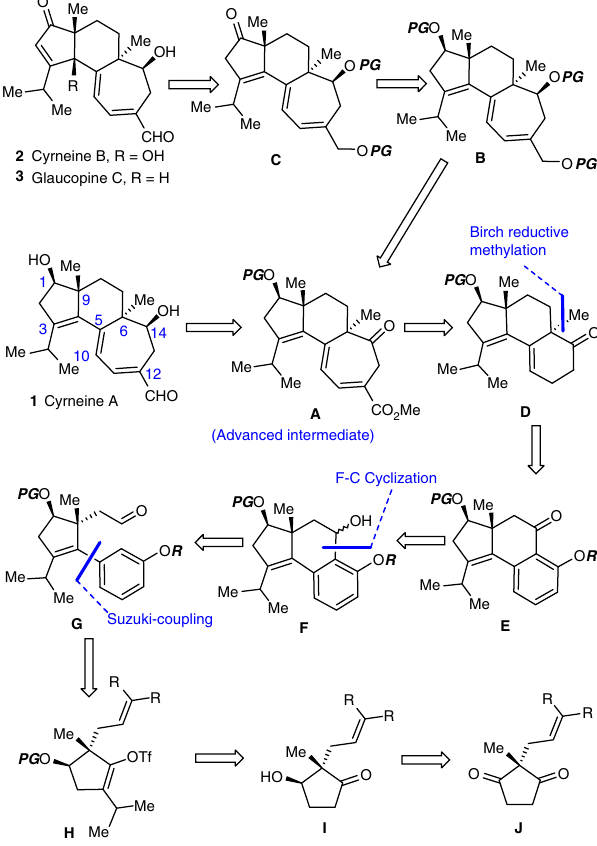
Fig. 2 Retrosynthetic analysis of cyrneine A − B and glaucopine C. PG stands for protecting group; F – C represents Friedel – Crafts; unless otherwise